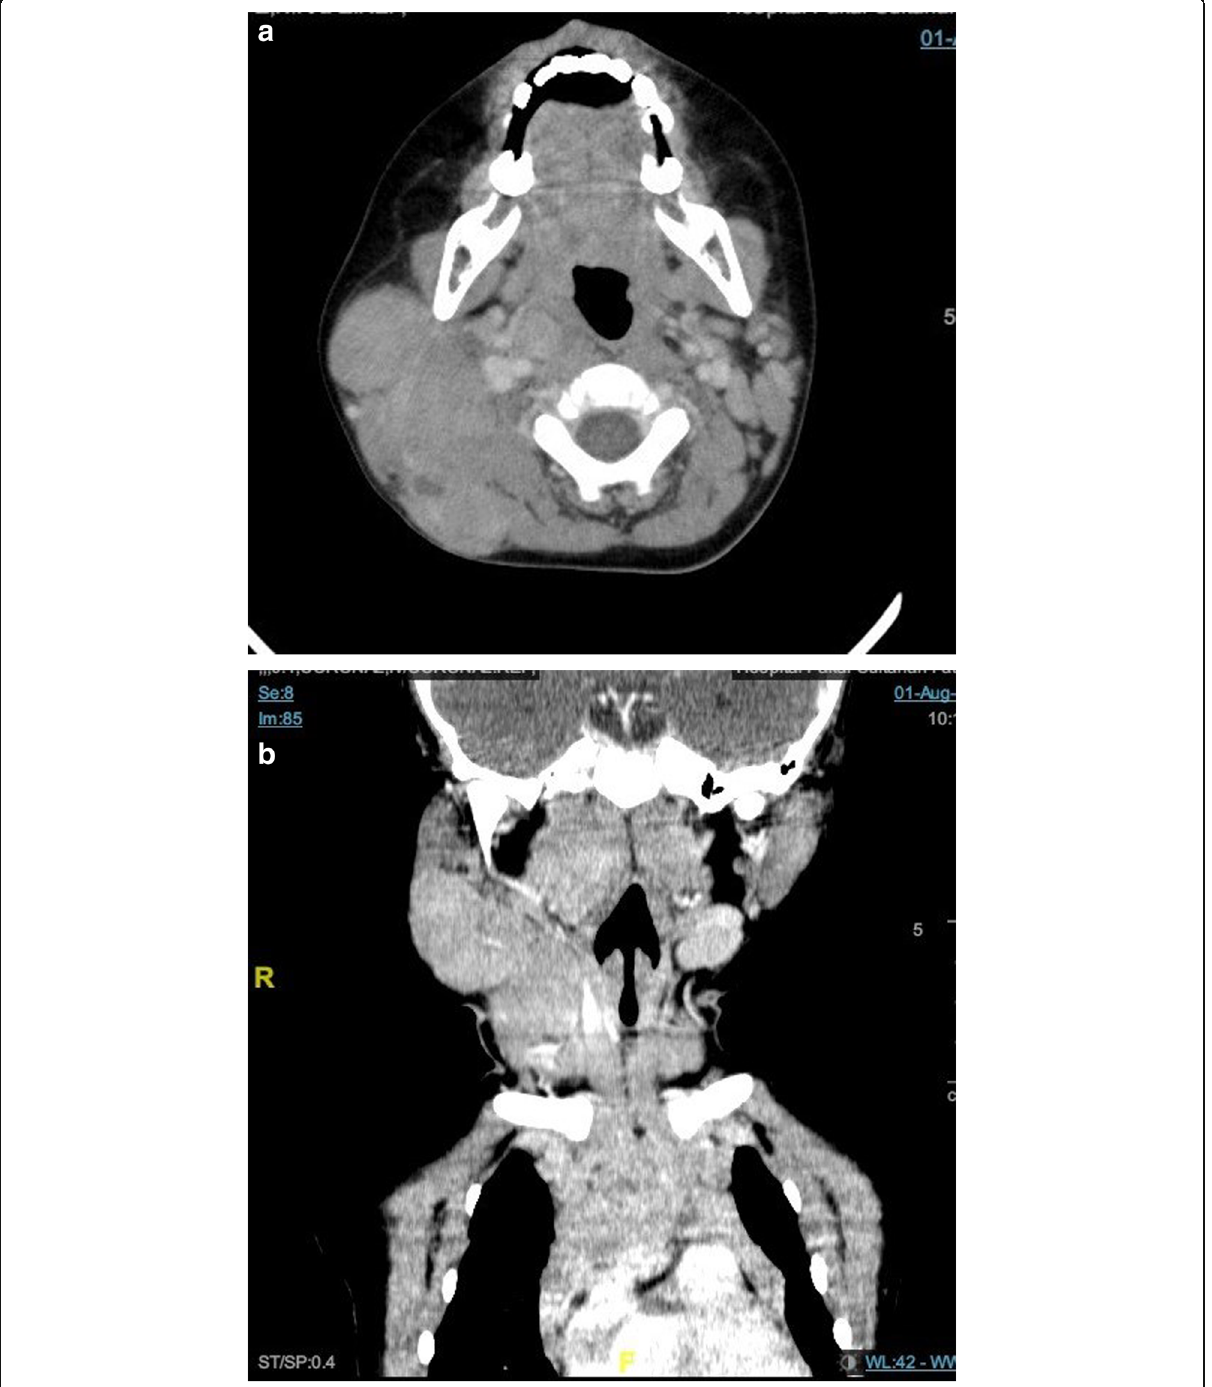
Fig. 2 a , b : multiple large lobulated LN seen in the bilateral cervical region more on the right side, predominantly involving level II,III,IV,V (white arrow) b : Right parapharyngeal space effaced, enlarged right retropharyngeal nodes causing mild effacement of the right nasopharynx and